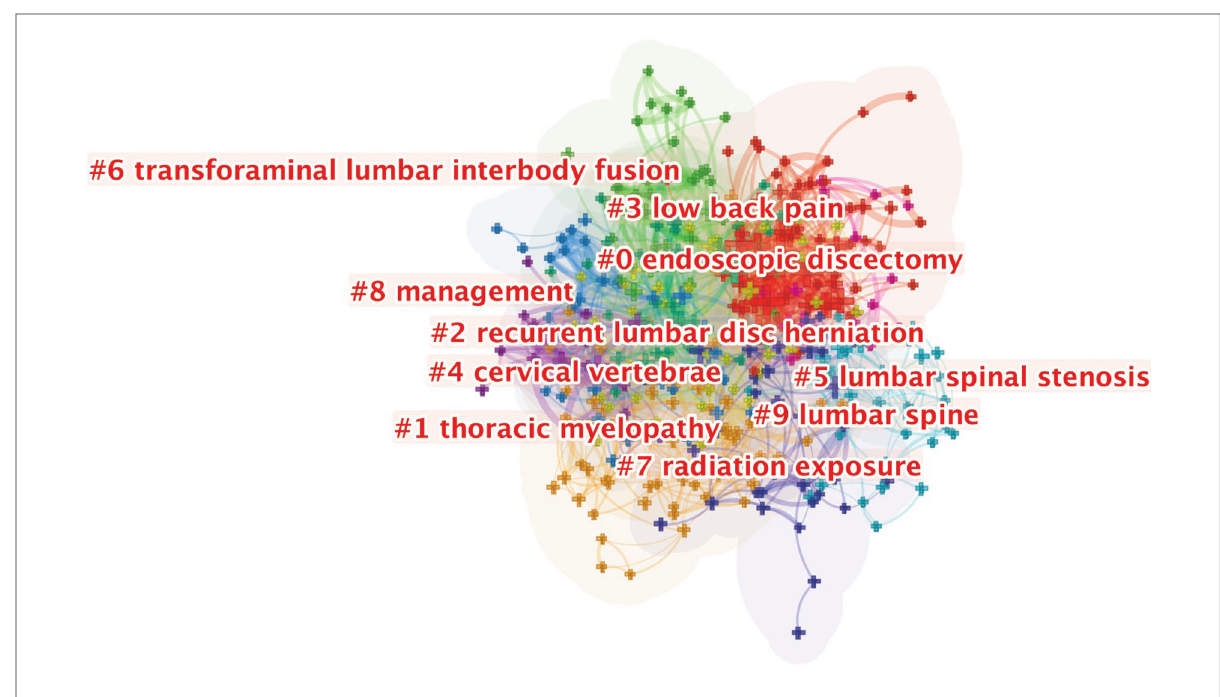
FIGURE 7 The clustering of